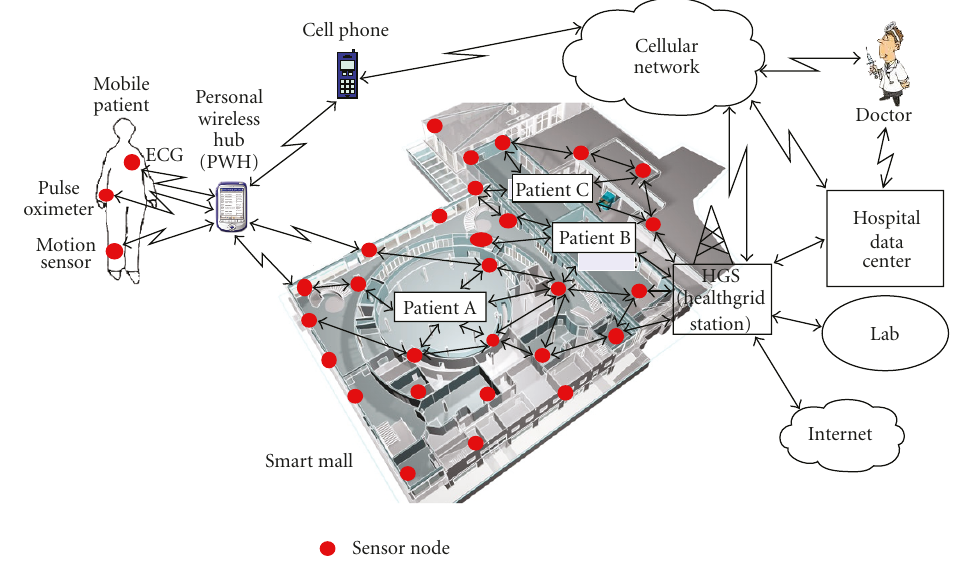
Figure 1: A mobile patient can communicate with hospital data center and/or physician through wireless networks (e.g., cellular and sensor networks), health grid station (HGS), and personal devices such as